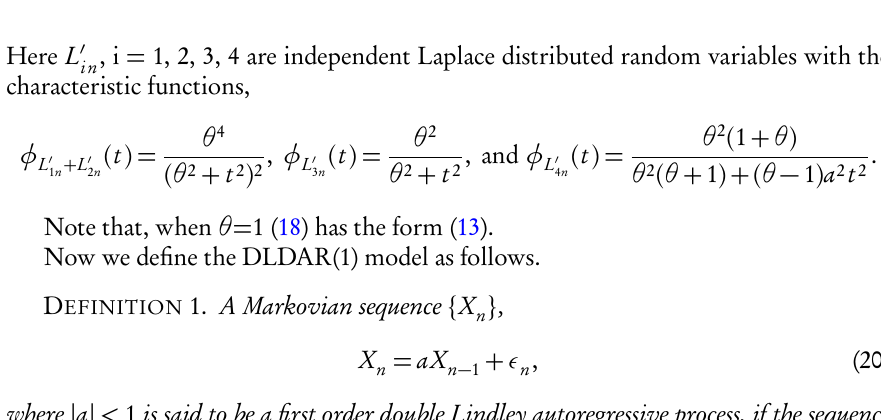
Figure 2 – Sample path of DLDAR ( 1 ) process for different values of a and θ